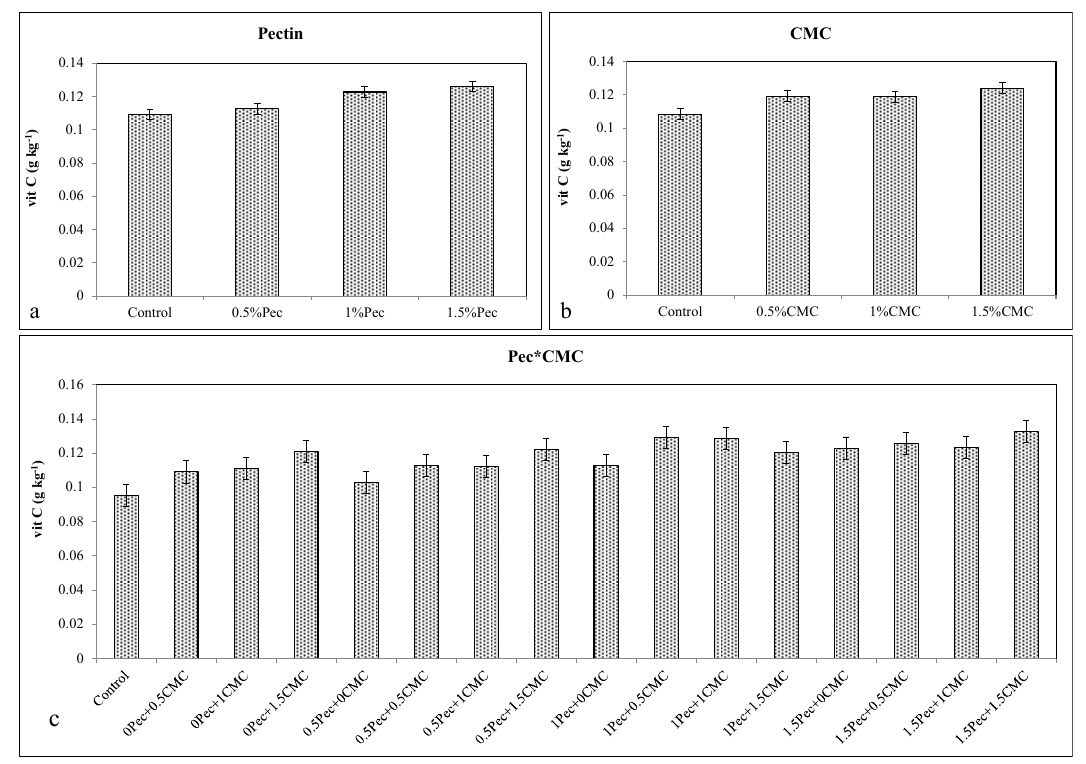
Figure 3. Effect of 0 (control), 0.5 (0.5% Pec), 1 (1% Pec) and 1.5 (1.5% Pec) % pectin-based edible coatings ( a ), 0 (control), 0.5 (0.5% CMC), 1 (1% CMC) and 1.5 (1.5% CMC) % carboxymethylcellulose-based edible coatings ( b ) and their combinations ( c ) on vitamin C (vit C) contents during cold storage period. Data are the “estimated marginal means ± 95% confidence intervals”. The results were expressed on a fresh weight basis. The columns with non-overlapping error bars are significantly different ( p ≤ 0.05).